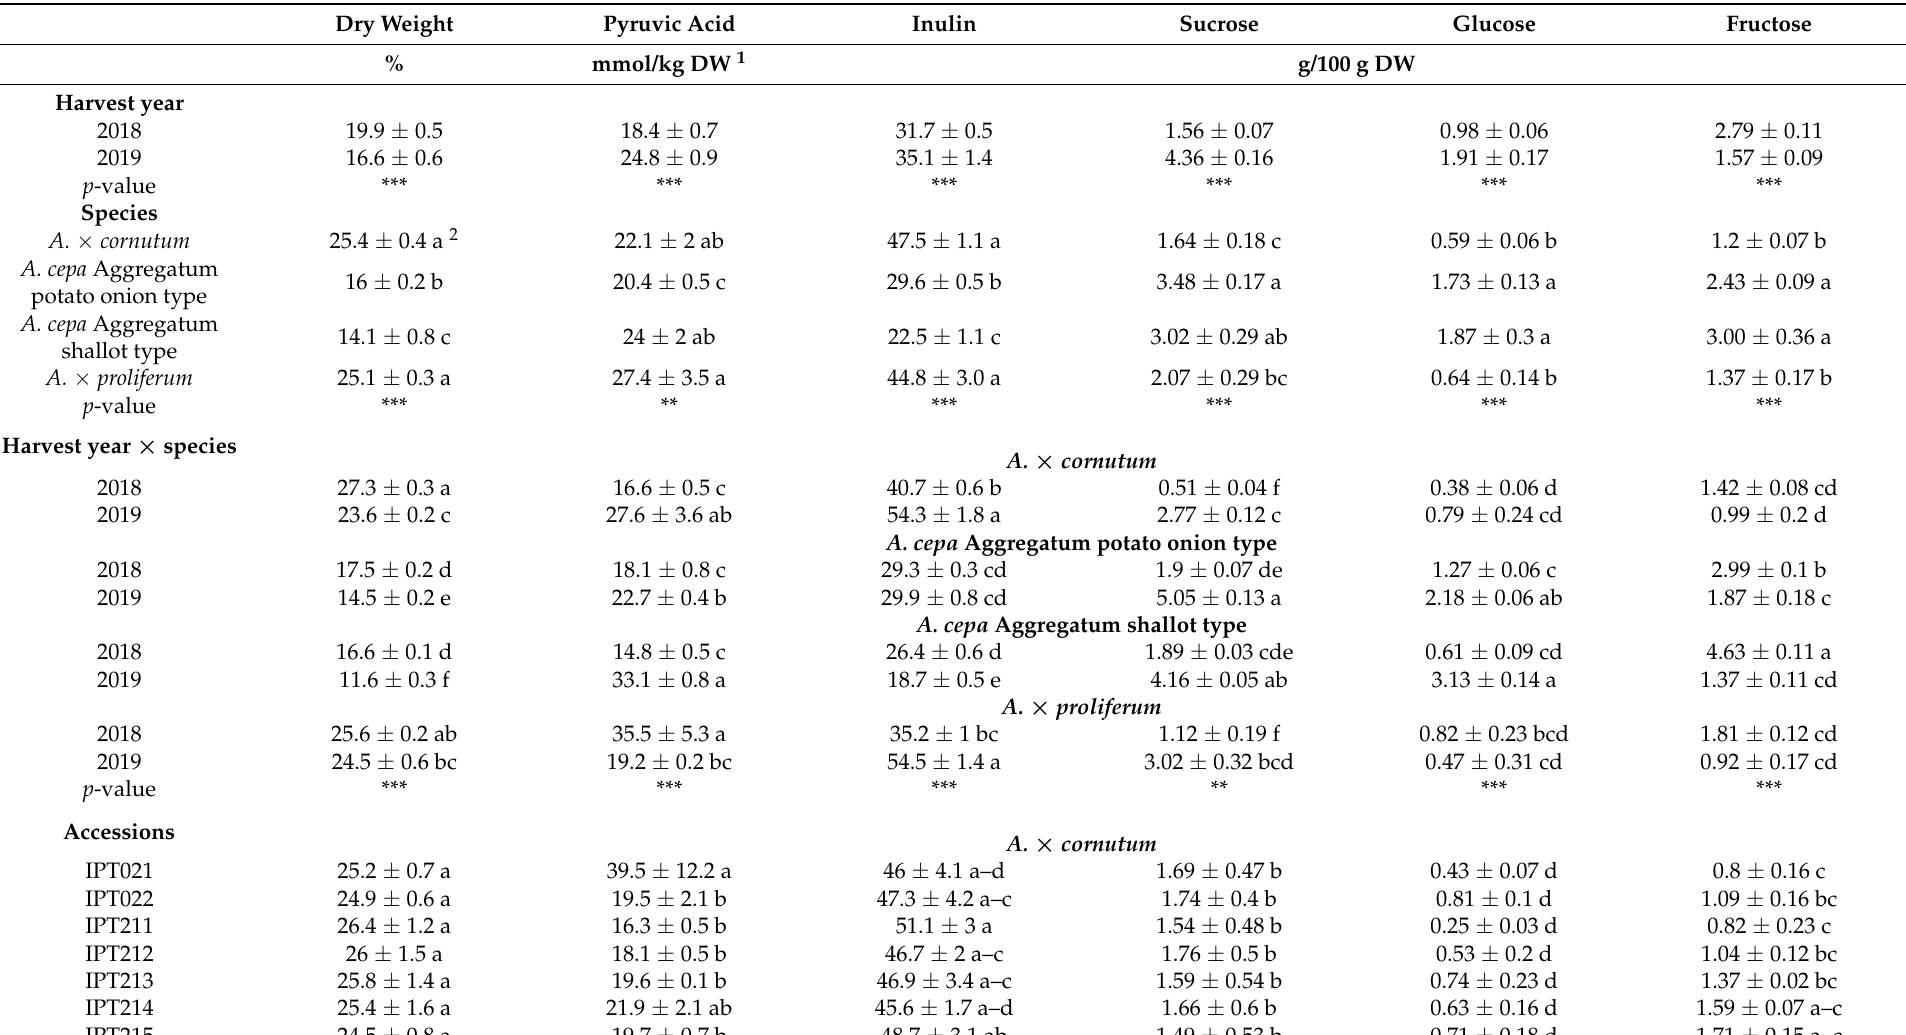
Table 1. Shallot dry weight, pyruvic acid content and sugar content by harvest year and species, their interactions and individual